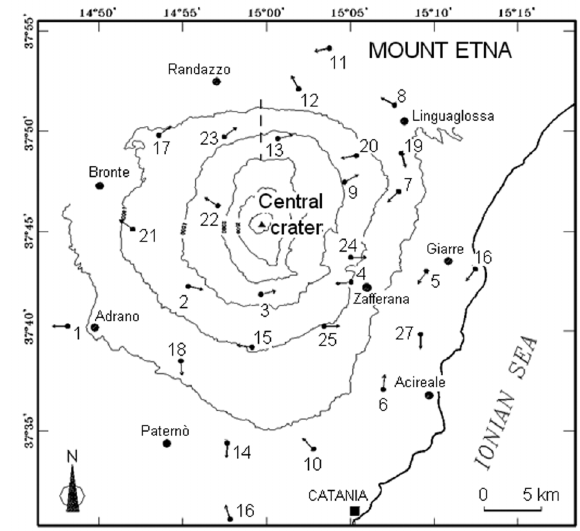
Fig. 9. A geographical sketch map of the Mt. Etna volcanic area corresponding to the gravity survey area, with indication of the sounding centers (dots) and expansion axes (arrows) of the dipole geoelectrical survey.